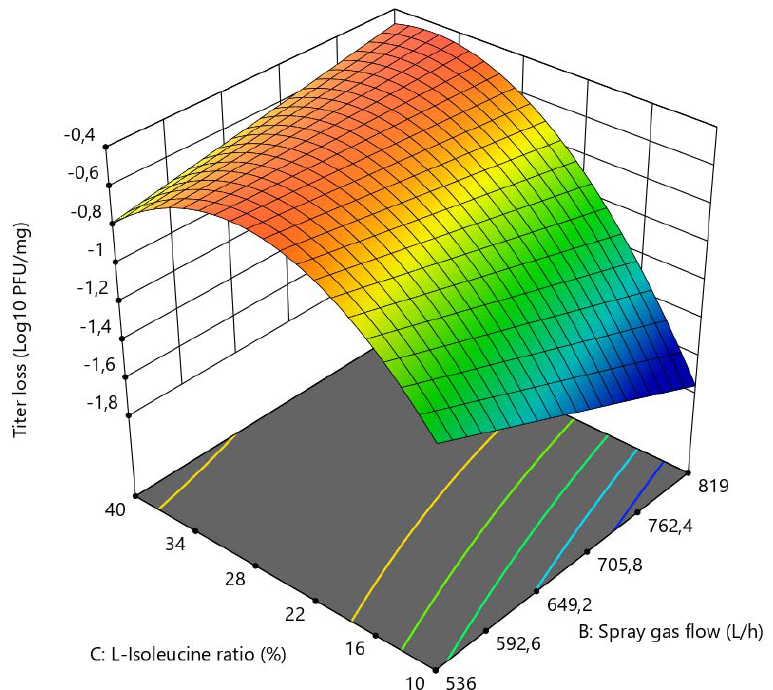
Figure 3. 3D surface graph showing bacteriophage LUZ19 activity (log 10 pfu/mg), in relation to L-isoleucine ratio (%) and spray gas flow (L/h).